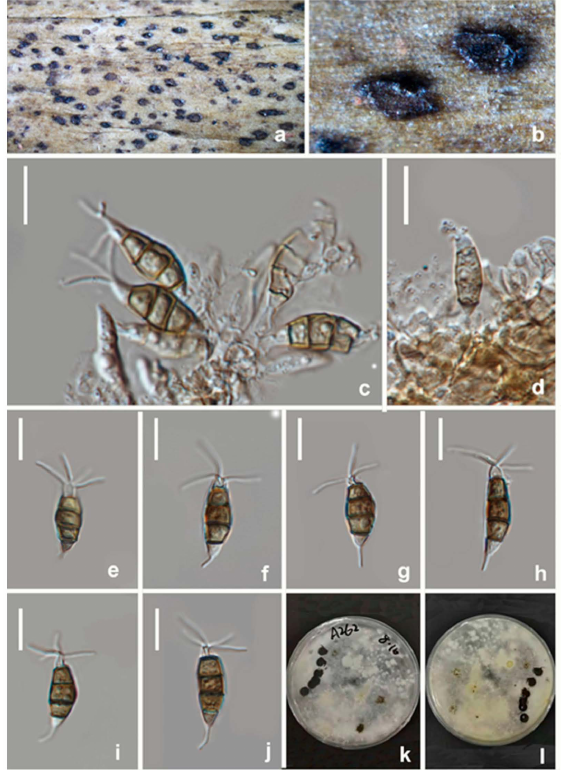
Figure 11. Pestalotiopsis kenyana (asexual morph, HKAS 123215) ( a , b ) Appearance of conidiomata on host substrate. ( c , d ) Conidiogenous cells and conidia. ( e – j ) Conidia. ( k , l ) Upper and reverse view of the colony on PDA. Scale bars: ( c – j ) = 10 µ